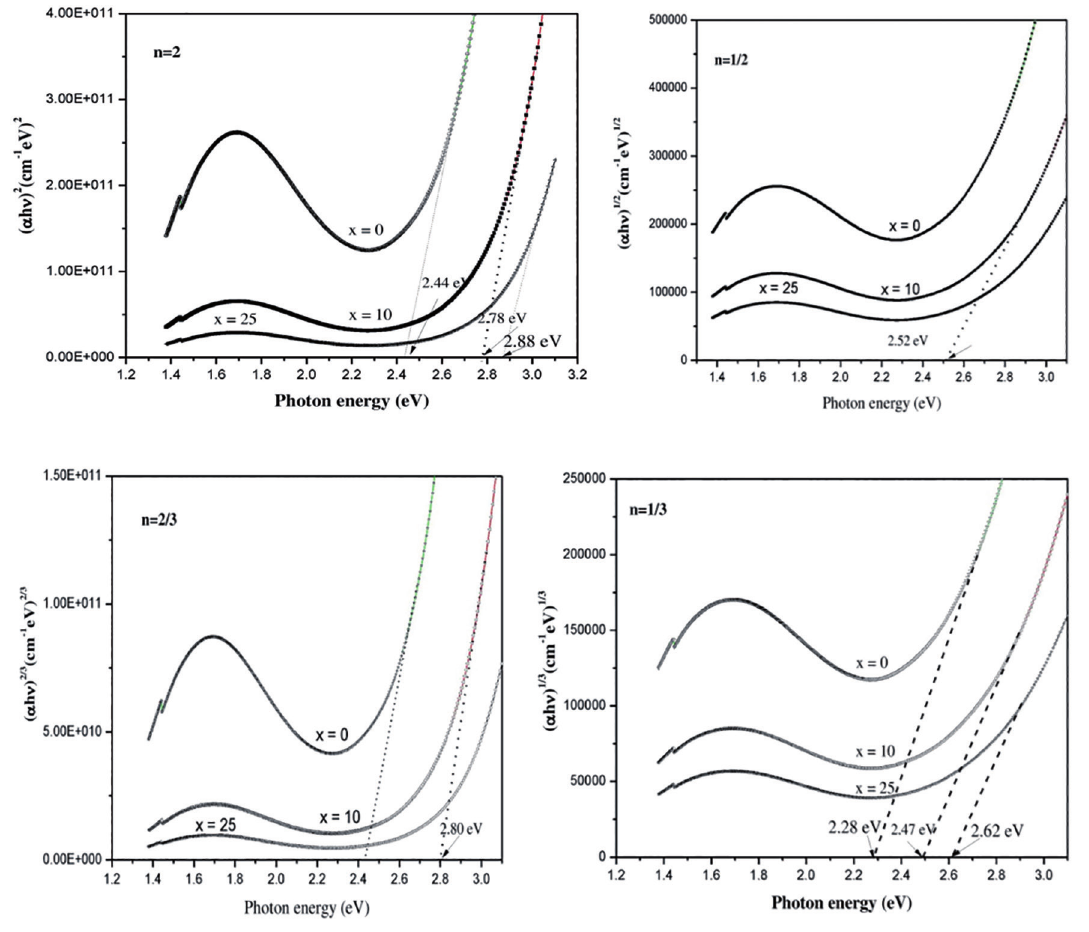
Figure 4: Tauc’s plots (n=1/2, 2, 2/3 and 1/3 ) for the present glass system. Table 2: Optical parameters of the present glass